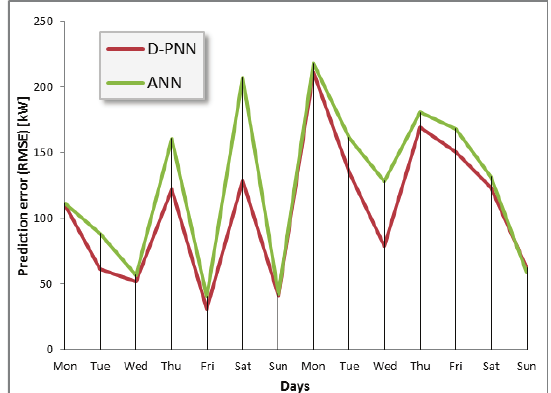
Fig. 10. 2-week daily predictions (30.1.2012 to